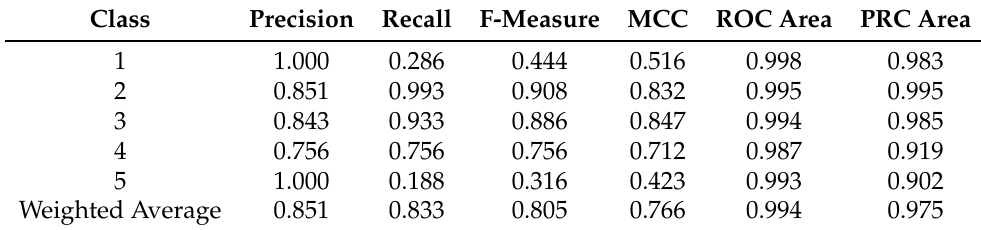
Table 24. RF accuracy